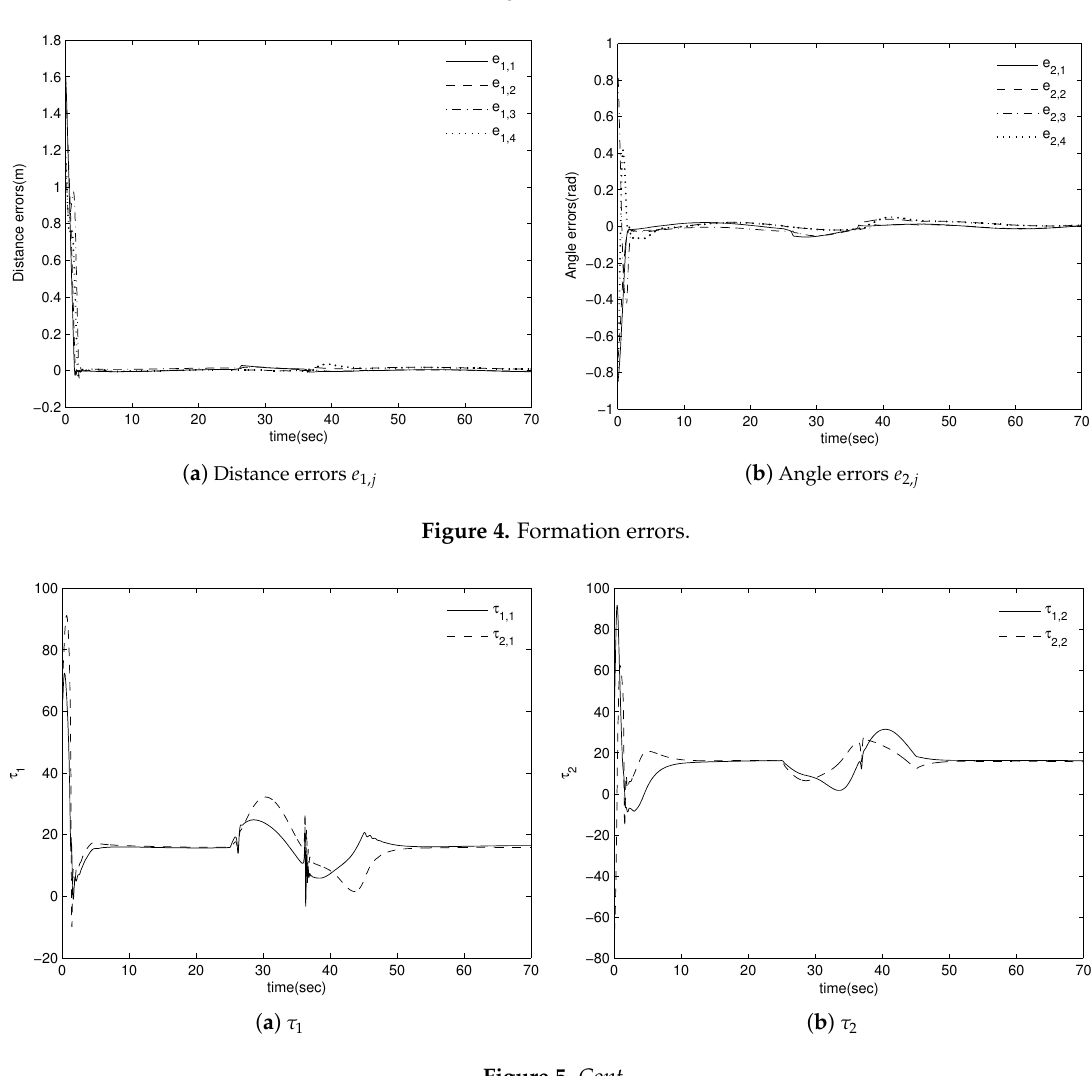
Figure 3. Formation tracking result.